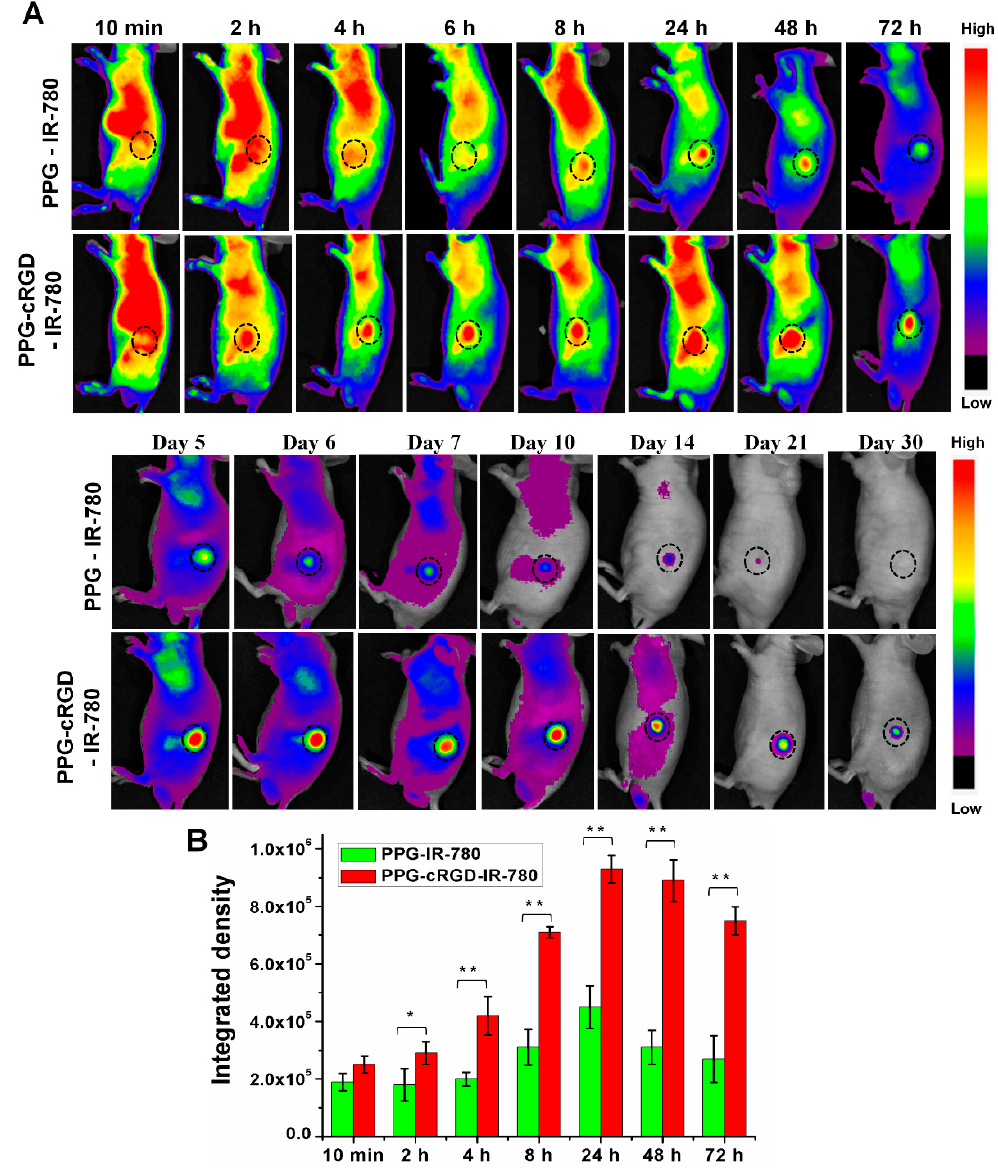
Figure 7. ( A ) Biodistribution analysis of PPG-IR-780 NPs and PPG-cRGD-IR-780 NPs in CT26 tumor-bearing nude mice after intravenous administration. Black circle indicates tumor region. ( n = 5). ( B ) Fluorescence intensity quantification of tumor region in a time-dependent manner. The data are shown as mean ± SD ( n = 5). * indicates p < 0.05 and ** indicates p < 0.01.